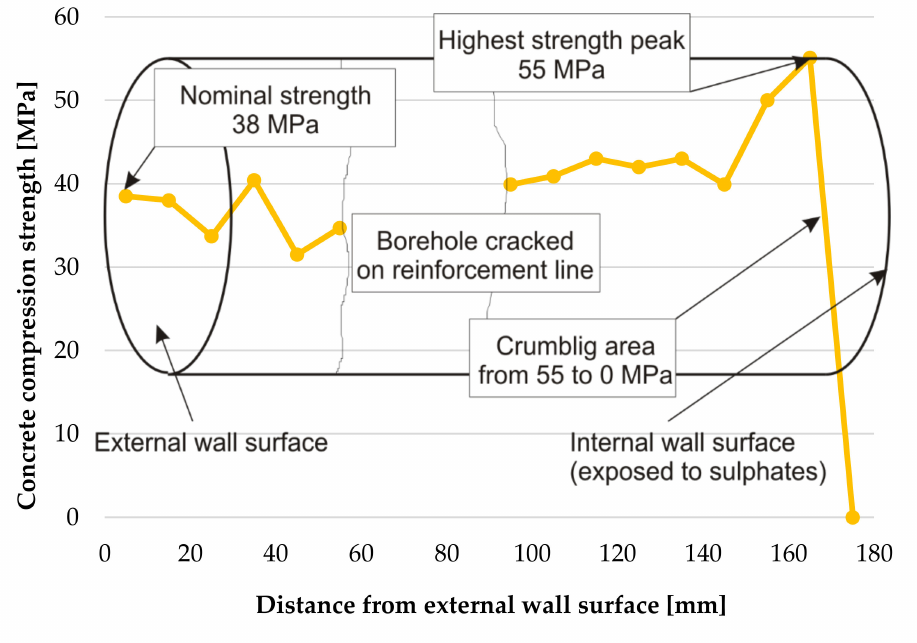
Figure 10. Change of concrete strength across the tank wall tested on borehole No.